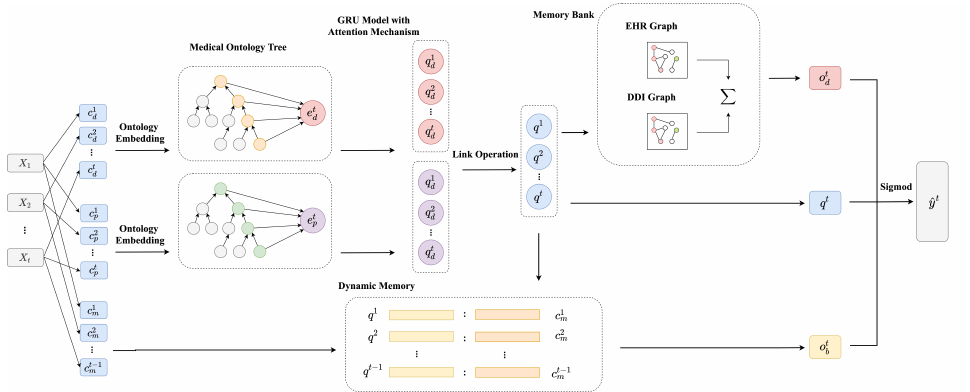
Figure 4. The framework of Med-tree. The standardized EHRs are divided into multi-hot representa- tions c t , c t p and c t m . Then, c t and c t p are input into the medical ontology tree to generate d d